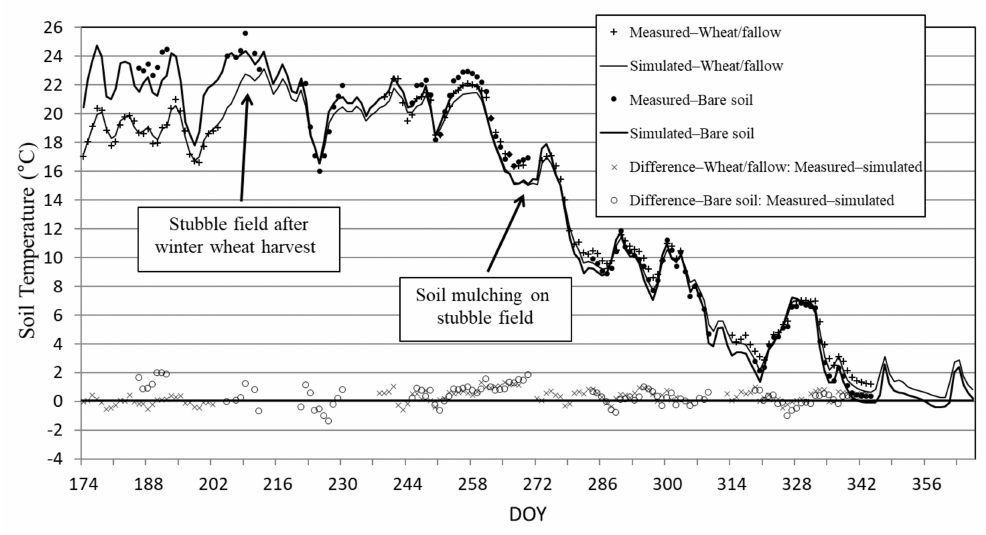
Figure 5. Measured and simulated daily mean soil temperatures at a soil depth of 20 cm in Goggendorf (Austria) under bare soil conditions and a winter wheat canopy from 22 June until 31 December 2016 (DOY = Day of